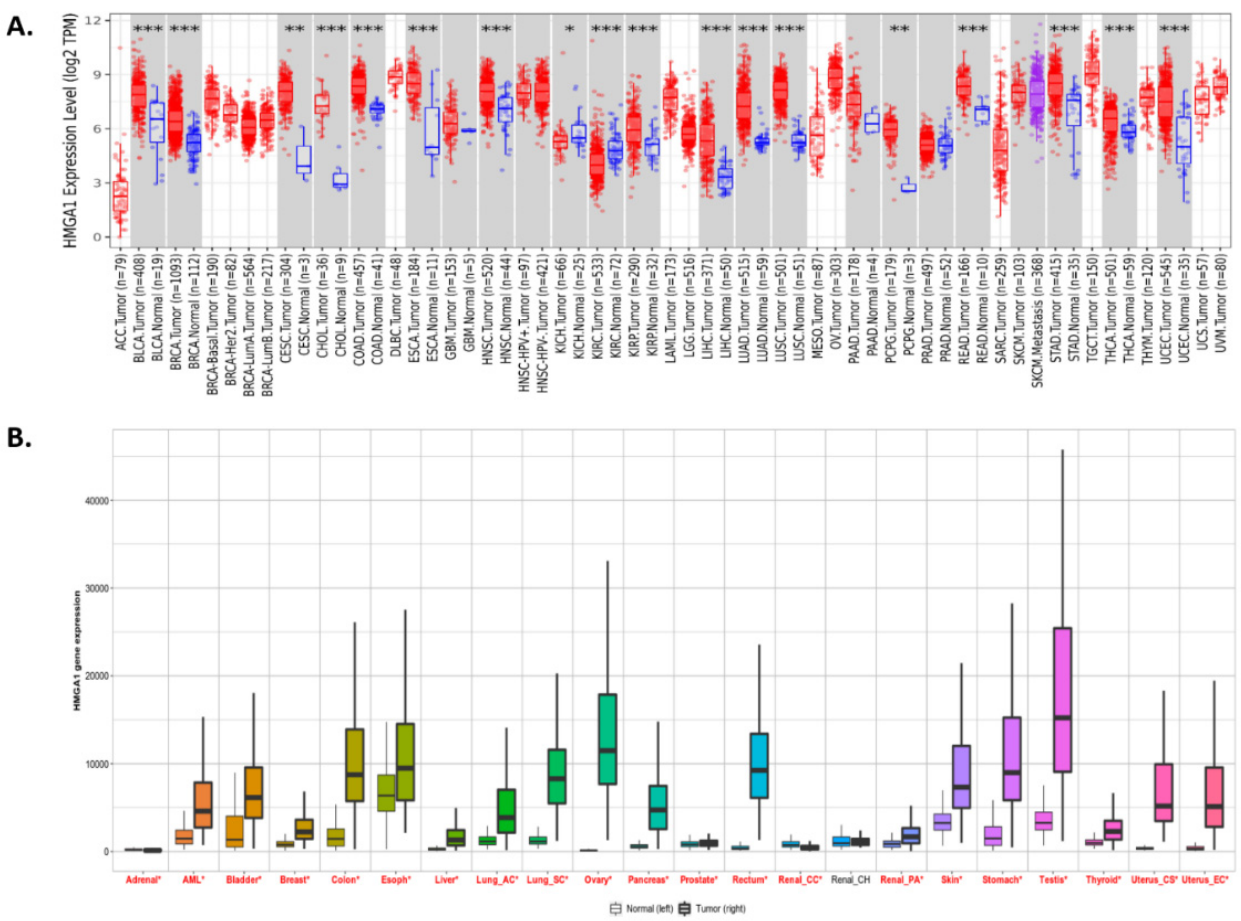
Figure 2. HMGA1 expression levels in different cancer types compared to the corresponding normal